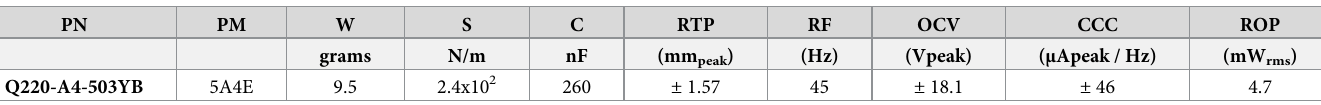
Table 6. The energy conversion efficiency and physical characteristic of piezoelectric transducer type QB220-503YB chosen for this study [23]. PN PM W S C RTP RF OCV CCC ROP grams N/m nF (mm peak ) (Hz) (Vpeak) ( μ Apeak / Hz) (mW rms ) Q220-A4-503YB 5A4E 9.5 2.4x10 2 260 ± 1.57 45 ± 18.1 ± 46 4.7 PN, Part Number; PM, Piezo Material; W, Weight; S, Stiffness; C, Capacitance; RTP, Rated Tip Deflection; RF, Rated Frequency; OCV, Open Circuit Voltage (At rated deflection, parallel operation); CCC, Closed Circuit Current (Per sinusoidal cycle, at rated deflection, parallel operation); ROP, Rated Output Power (At rated deflection and